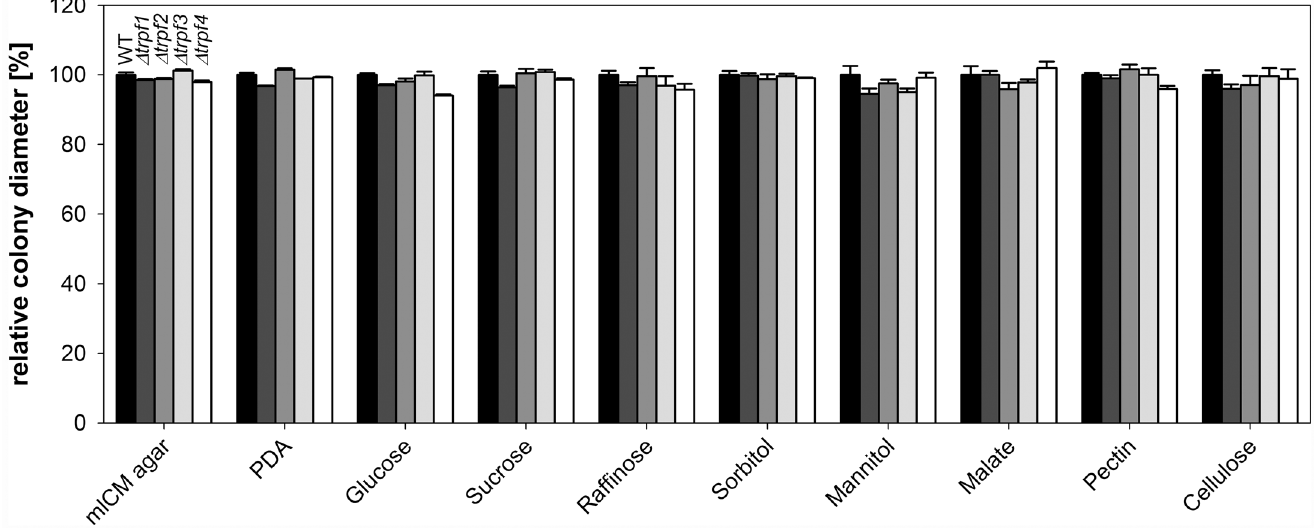
Fig 6. Growth of C . graminicola colonies on different carbon sources. Growth was assessed on mLCM agar, PDA, and minimal media administered with 2% of the respective carbon source. All values were normalized to the growth of the wild type on the respective medium. Colony diameter was measured 117 hours post inoculation. Data are means ± SE (N =